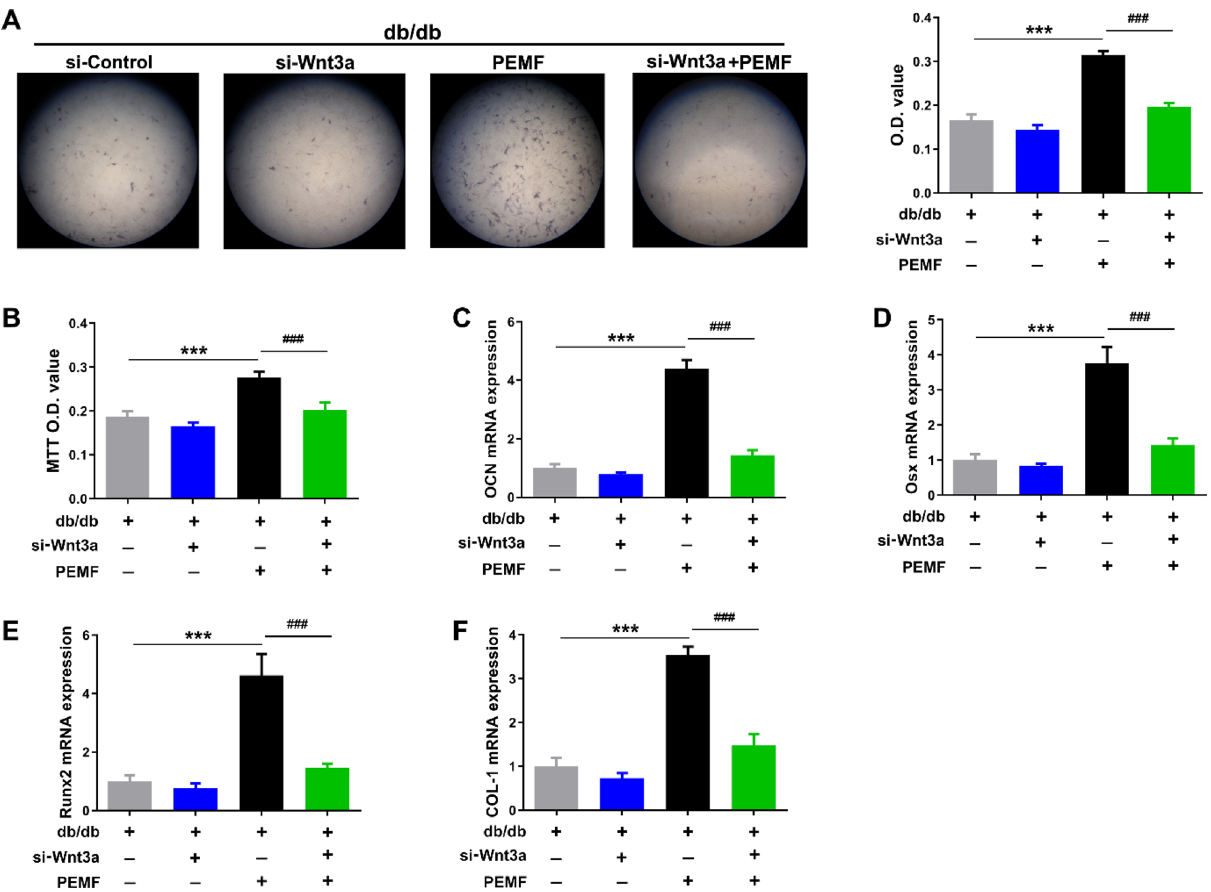
Figure 6. Pulsed electromagnetic fields (PEMF)-induced improvement in cellular differentiation and proliferation of in vitro osteoblasts isolated from mandibular bone of db/db mice is inhibited after Wnt3a silencing. ( A ) Osteoblast differentiation assays based on alkaline phosphatase staining. ( B ) MTT assays for primary osteoblast proliferation. ( C–F ) Analysis of osteoblastic differentiation-related gene expression, including osteocalcin (OCN), Runx2, Osx and COL-1. Data are represented as mean ± SEM ( n = 7–10/group). *** P < 0.001 vs. the db/db mice group; ### P < 0.001 vs. the db/db mice with PEMF exposure group by one way analysis of variance (ANOVA) followed by Bonferroni’s multiple